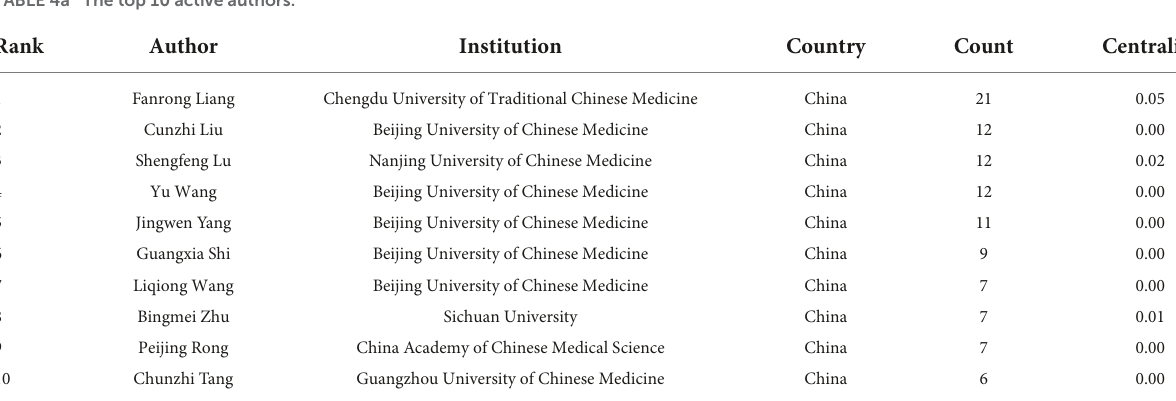
TABLE 4a The top 10 active